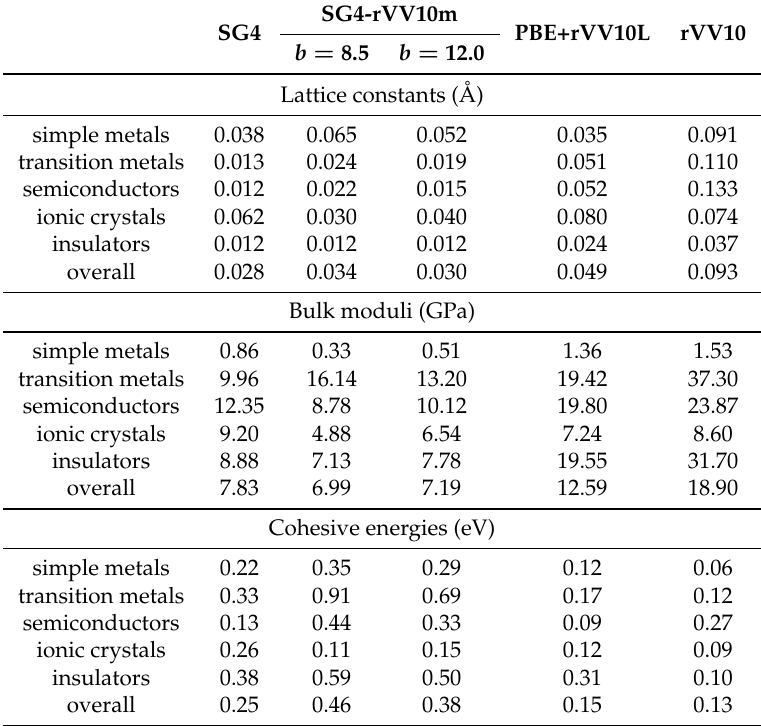
Table 5. Mean absolute errors on lattice constants, bulk moduli, and cohesive energies of different classes of iono-covalent bulk solids as obtained with different